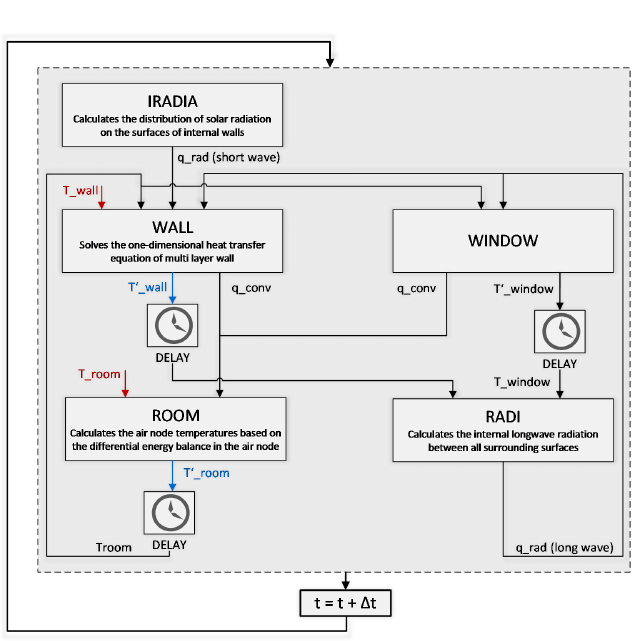
Figure 2. Building model node interconnections. Own representation based on